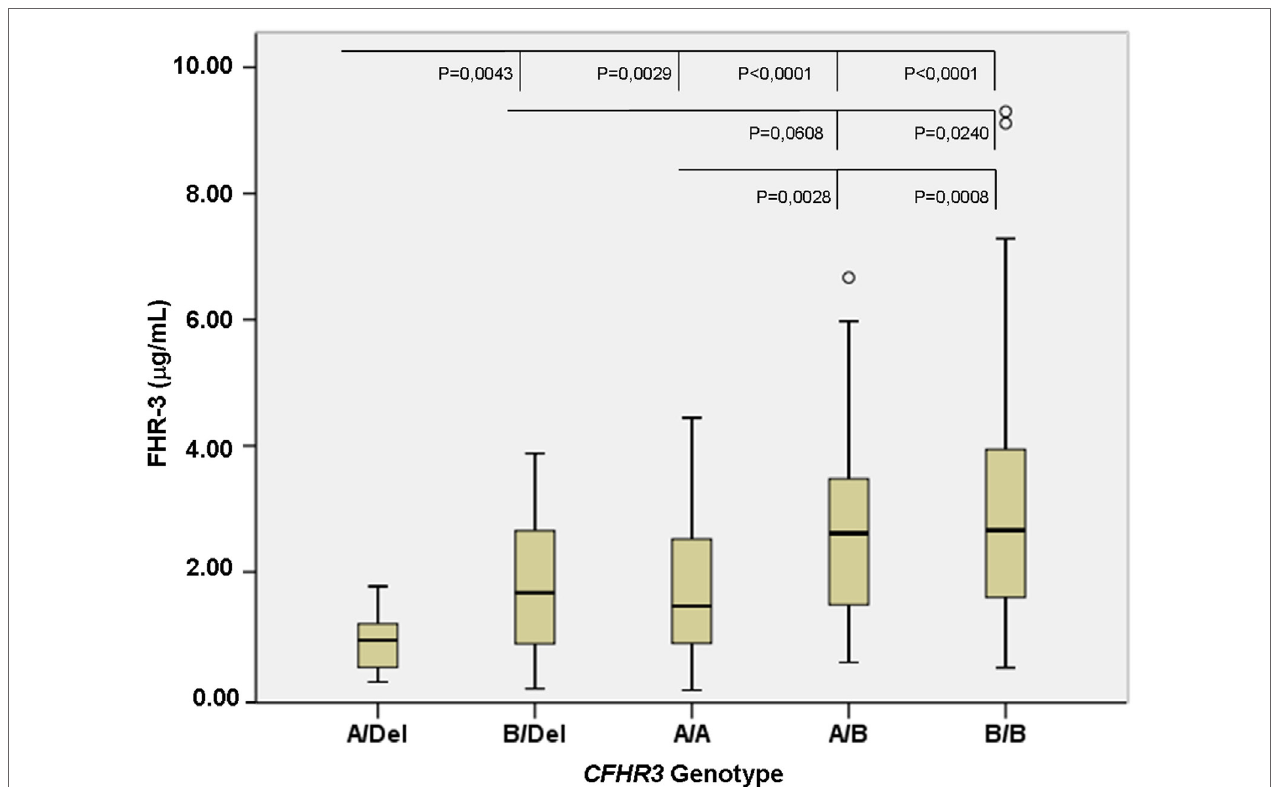
FigUre 2 | FHR-3 levels are associated with the CFHR3*A/B/Del genotypes. Boxplot of FHR-3 levels in 208 patients with atypical hemolytic uremic syndrome who were grouped according to their CFHR3 genotype; patients with the CFHR3 Del/Del genotype were not included because they have homozygous FHR-3 deficiency. The statistical significance obtained in pairwise two-sided multiple comparisons is also shown. Outliers in the CFHR3 A/B and B/B genotype groups are denoted by symbols